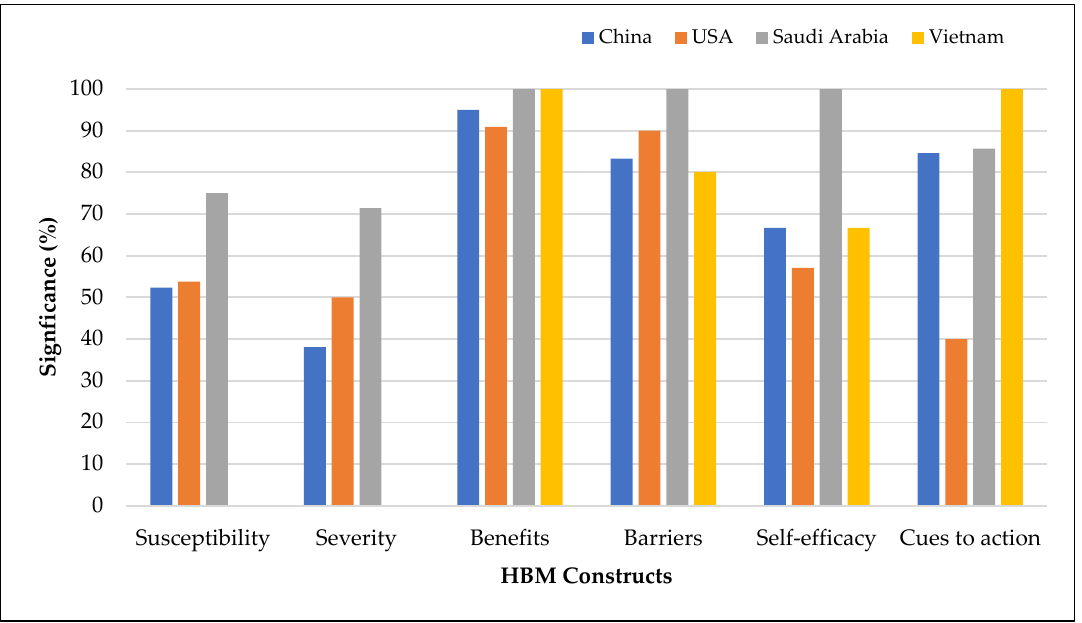
Figure 8. Health belief model constructs associated with vaccination intention by country with five or more studies.